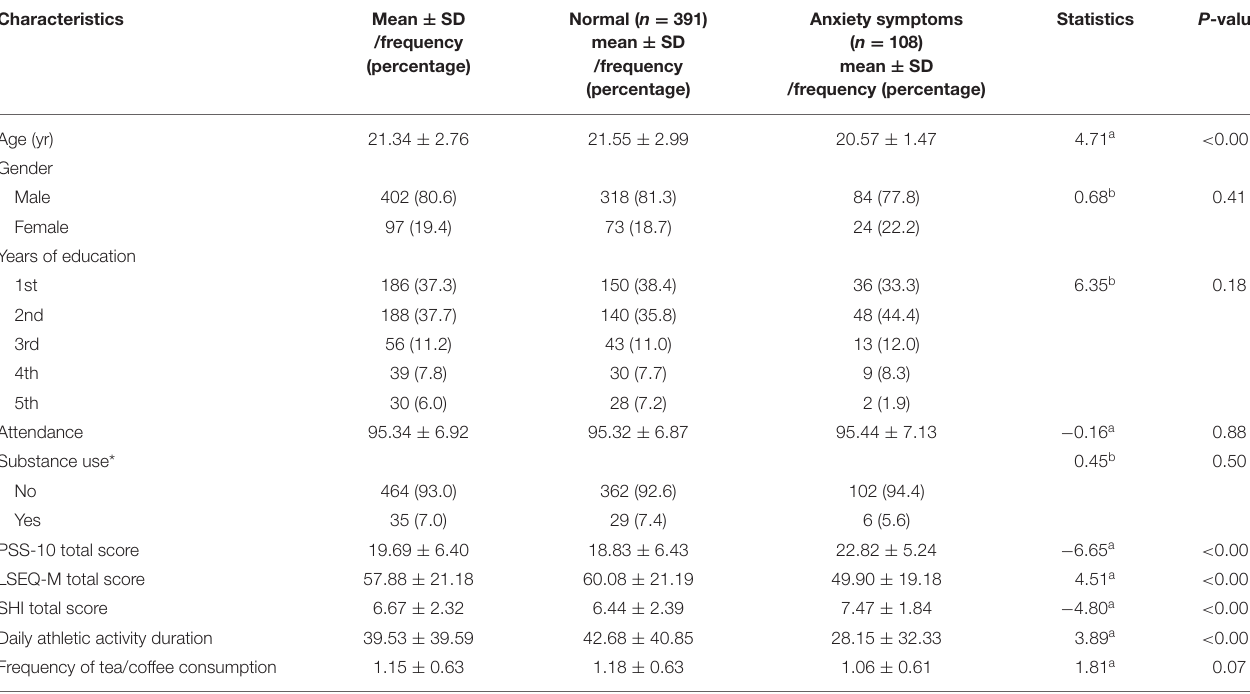
TABLE 1 | Participants’ characteristics and their relationship (bivariate) with anxiety in Ethiopian collegiate young adults. Characteristics